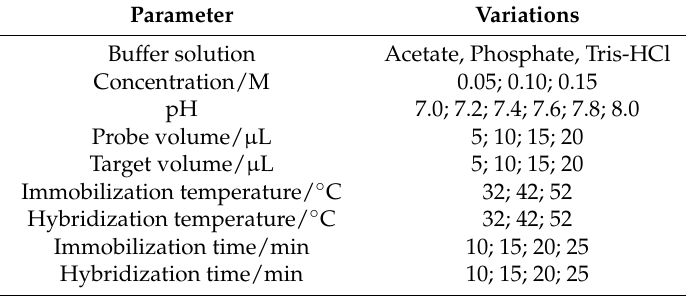
Table 1. Parameters investigated for construction of the genosensor.